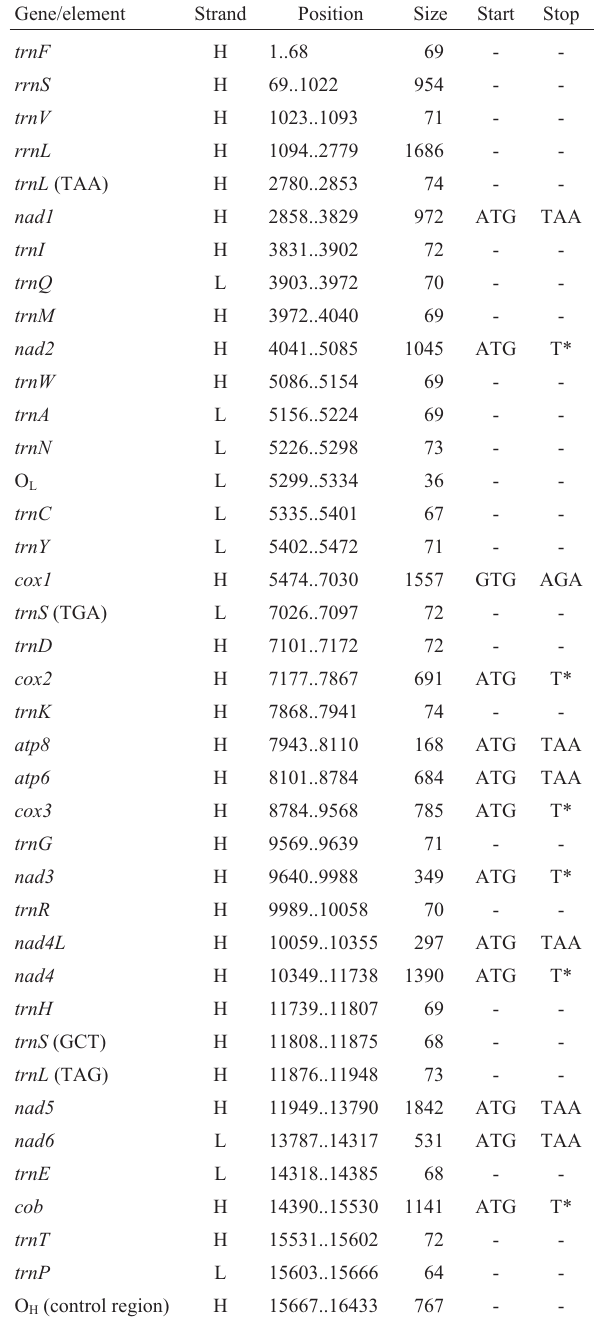
Table 2 - Gene organization of the Arapaima gigas mitochondrial ge-